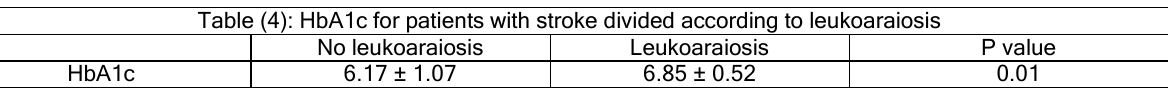
Table (4): HbA1c for patients with stroke divided according to